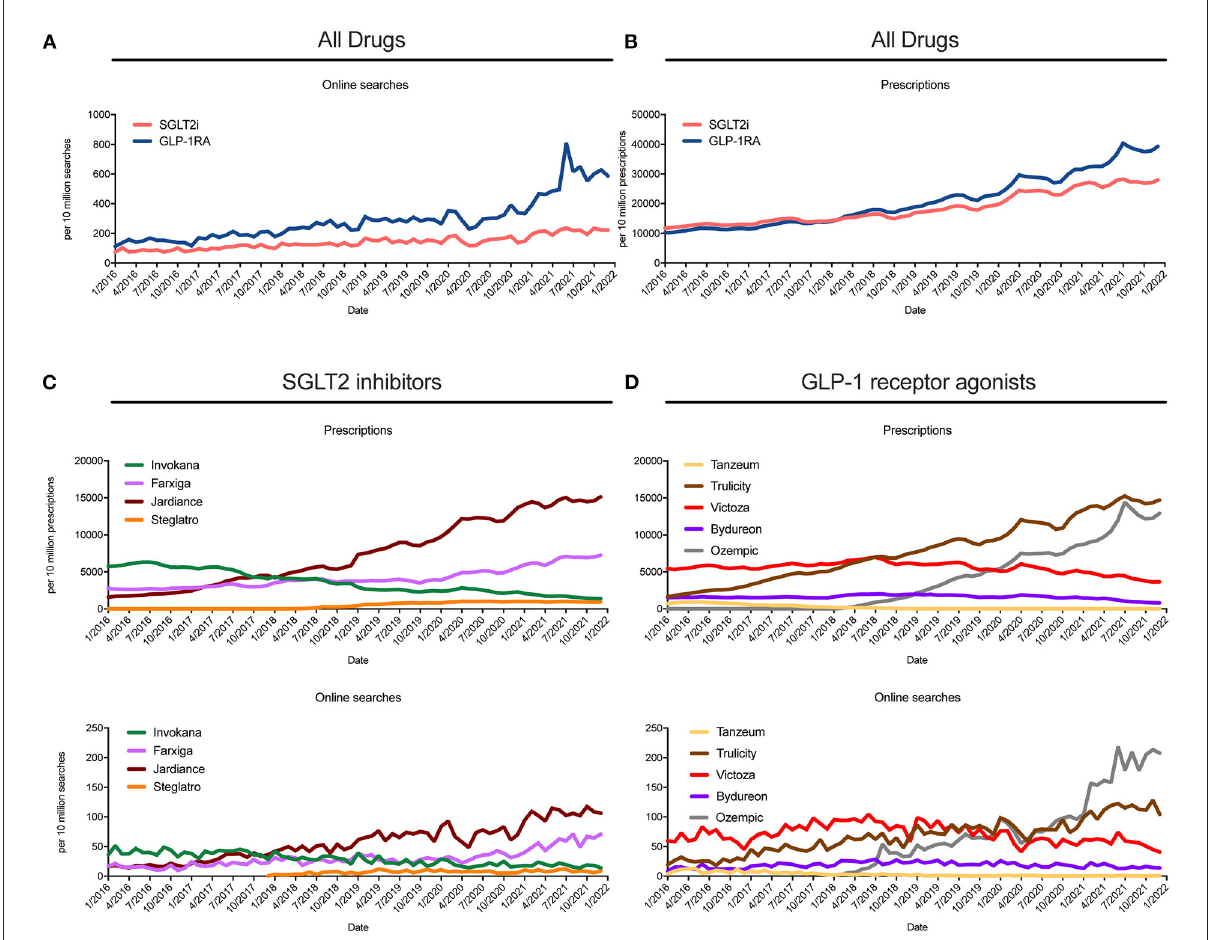
FIGURE1 Trends in prescriptions and online searches for SGLT2i and GLP-1 RA brands between 2016 and 2021 for the United States. (A) Online searches and (B) prescriptions from 2016 to 2021 for SGLT2i (red line) and GLP-1 RA (blue line) as monthly query fraction/prescriptions per 10 million searches/prescriptions for summarized brands names are shown. (C) Trends in prescriptions (upper panel) and online searches (lower panel) for 4 selected SGLT2i brand names. (D) Trends in prescriptions (upper panel) and online searches (lower panel) for 5 selected GLP-1 RA brand names. All data are representative for the United